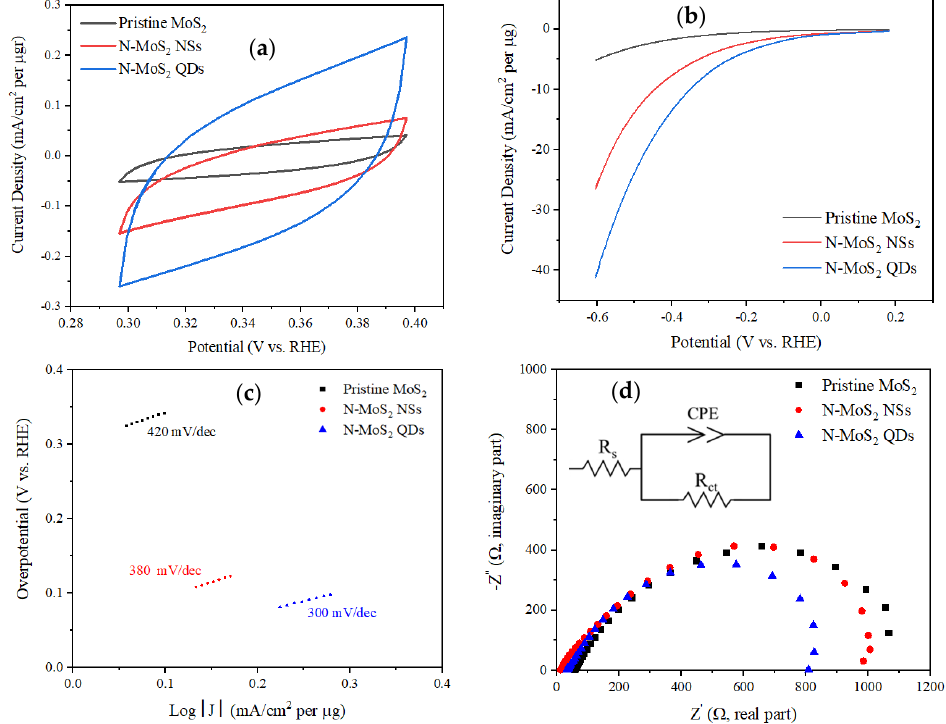
Figure 6. ( a ) Typical CV curves of the pristine MoS 2 , N ‐ MoS 2 NSs and N ‐ MoS 2 QDs in 0.5 M H 2 SO 4 electrolyte at a scan rate of 20 mV/s ( b ) LSV graphs in 0.5 M H 2 SO 4 with scan rate of 2 mV/s, ( c ) corresponding Tafel plots of the pristine MoS 2 , N ‐ MoS 2 NSs and N ‐ MoS 2 QDs and ( d ) Nyquist plots of the samples of interest in 0.5 M H 2 SO 4 . The inset shows the Randles equivalent circuit for the fitting of EIS data which R s and CPE denote the solution resistance and constant phase element, respectively. Note that, the smaller Tafel plot slope indicates the larger catalytic activity for HER performance. Furthermore, N ‐ MoS 2 QDs exhibit a less R ct value due to a smaller semicircle diameter. LSV measurements are carried out in a 0.5 M H 2 SO 4 solution with a scanning rate of 2 mV/s at room temperature to assess the catalytic activity in HER of the N ‐ MoS 2 NSs and QDs using current density (J) versus applied voltage (V) as J − V curves. Figure 6b,c illus ‐ trate the obtained cathodic polarization curves and corresponding Tafel plots, respec ‐ tively, in favor of three samples of interest, i.e., pristine MoS 2 , N ‐ MoS 2 NSs, N ‐ MoS 2 QDs. It can be seen that the N ‐ MoS 2 NSs and N ‐ MoS 2 QDs benefit significantly lower onset overpotentials ( η ) against the pristine MoS 2 . For instance, at a given current of − 10 mA/cm 2 per μ g, the η value of N ‐ MoS 2 NSs and N ‐ MoS 2 QDs are − 0.45 and − 0.35 V (versus RHE), respectively. The N ‐ MoS 2 QDs reveal the lowest value of onset potential, indicating out ‐ standing HER activity. Additionally, as shown in Figure 6b, the cathodic current densities per μ g of N ‐ MoS 2 NSs and N ‐ MoS 2 QDs ( η = 0.6 V) are obtained as 26.25 and 41.42 mA/cm 2 per μ g, respectively. This values are five and eight times greater than that of the pristine MoS 2 (5.2 mA/cm 2 per μ g). Thereby, the HER enhancement is verified in favor of N ‐ MoS 2 NSs and N ‐ MoS 2 QDs according to LSV spectra. On the other hand, Tafel slope is an essential property of the electrocatalysts materi ‐ als to show the kinetics of the HER process. The Tafel slope defines the overpotential in ‐ crement corresponding to the higher reaction rate by a factor of ten. This is determined by the magnitude of the change in the activation energy for a given increase of the larger overpotential. A low Tafel slope corresponds to higher HER activity. In fact, a smaller voltage must be applied to obtain a given current according to the lower Tafel slope. Thus, more current can be produced with less power consumption [74]. The Tafel plots in Figure